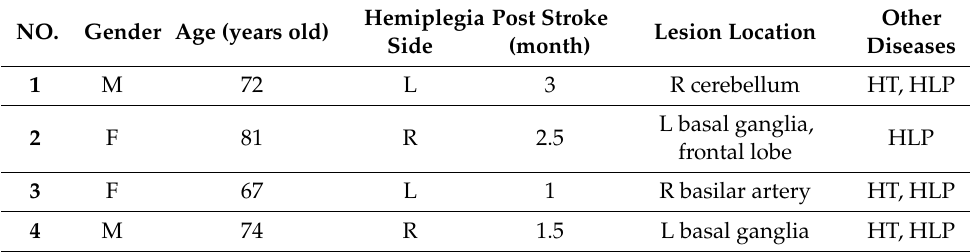
Table 2. Clinical characteristic of patients with cerebral